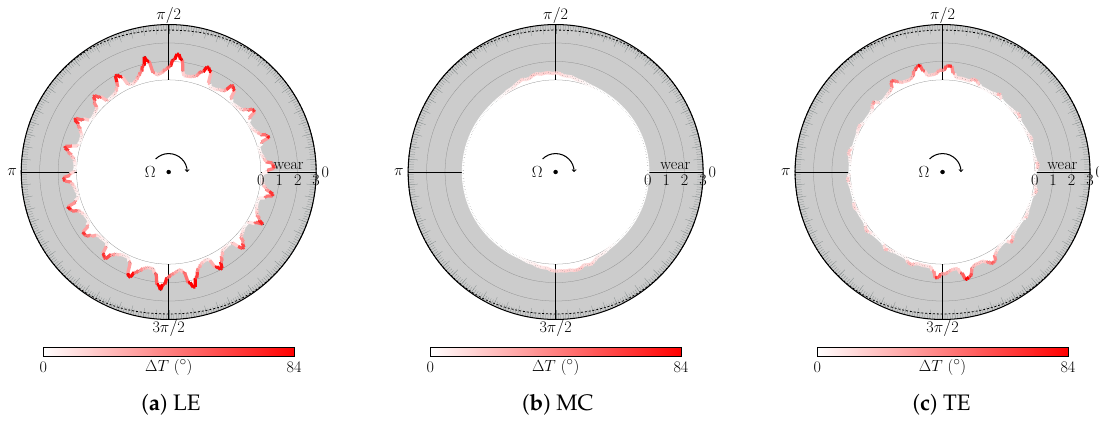
Figure 13. Wear and temperature profiles at 0.51 s for the HP compressor test